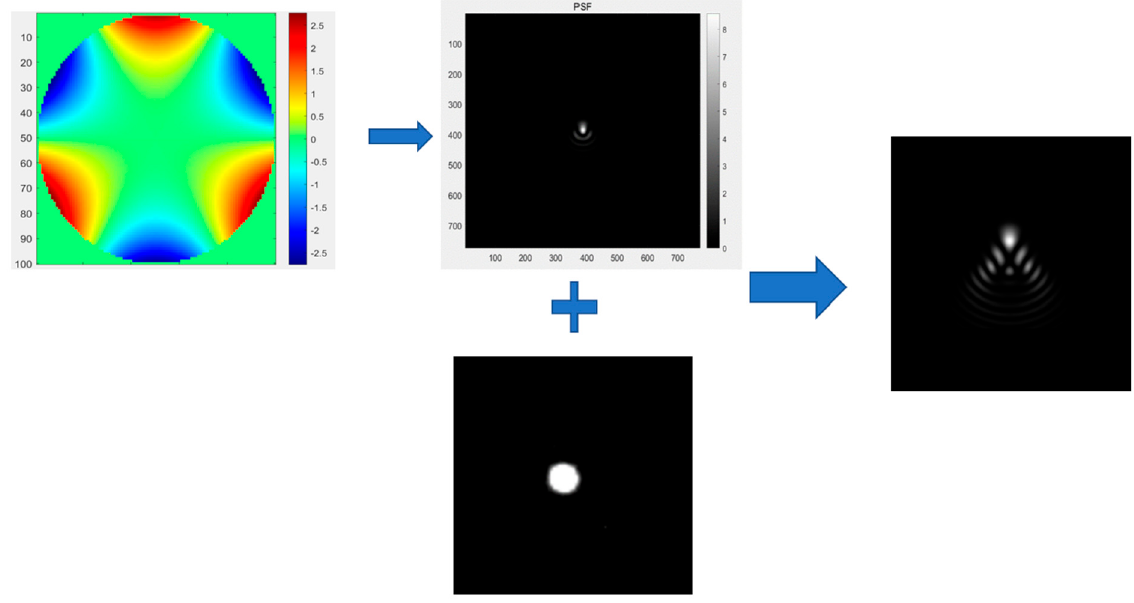
Figure 5. Use the generated PSF to convolute with the selected ideal star to obtain the image of optical aberration.